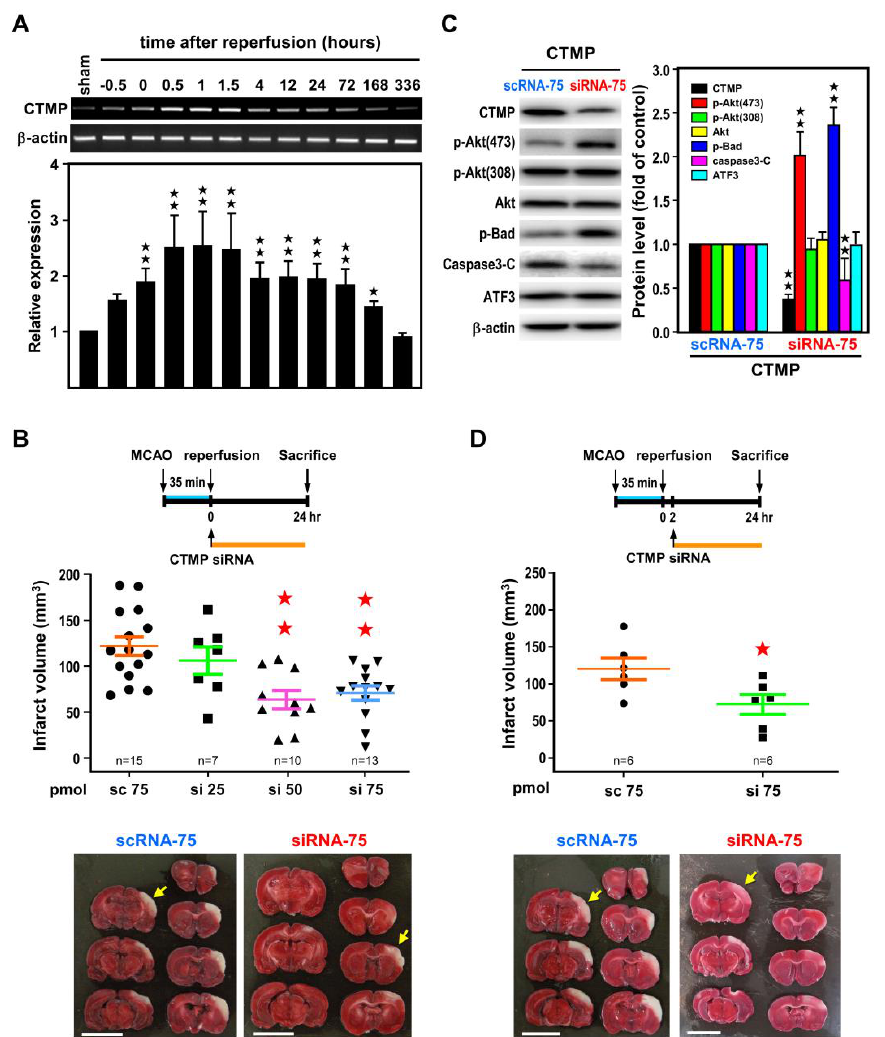
Figure 6. Reduction in ischemic brain injury with post-ischemic CTMP siRNA treatment. ( A ) A time-course study of CTMP mRNA levels in the ischemic cortices of rats subjected to 60 min of MCA occlusion and various reperfusion periods as in Figure 1. Three rats for each group and each band represents a data point that was extracted from an independent brain sample. Representative RT-PCR bands are shown in the upper panel and bar graphs below are compiled data shown as mean ± SD ( n = 3). ( B ) Rats were subjected to icv infusion of CTMP siRNA at 25, 50, or 75 pmol (si 25, si 50, or si 75, respectively) or 75 pmol of scramble RNA (sc 75) right after 35 min of MCA occlusion, and infarct volume was measured at 24 h of reperfusion. Representative images of brain infarct are shown at the bottom. ( C ) The apoptosis-related proteins were measured at 24 h of reperfusion. Three rats for each group and each band represents a data point that was extracted from an independent brain sample. Representative Western blot bands are shown in the left and bar graphs aside are compiled data shown as mean ± SD ( n = 3). ( D ) Rats were subjected to icv infusion of CTMP siRNA 2 h after 35 min of MCA occlusion, and infarct volume were measured at 24 h of reperfusion. Representative images of brain infarct are shown at the bottom. Data are expressed as mean ± SD ( n ≧ 6). ★ p < 0.05 and ★★ p < 0.01 vs. controls. White area represents infarct area (yellow arrow). (Bars = 1 cm). CTMP: carboxyl-terminal modulator protein; ATF3: activating transcription factor 3; MCAO: middle cerebral artery occlusion; scRNA: scramble RNA; siRNA: small interfering RNA.